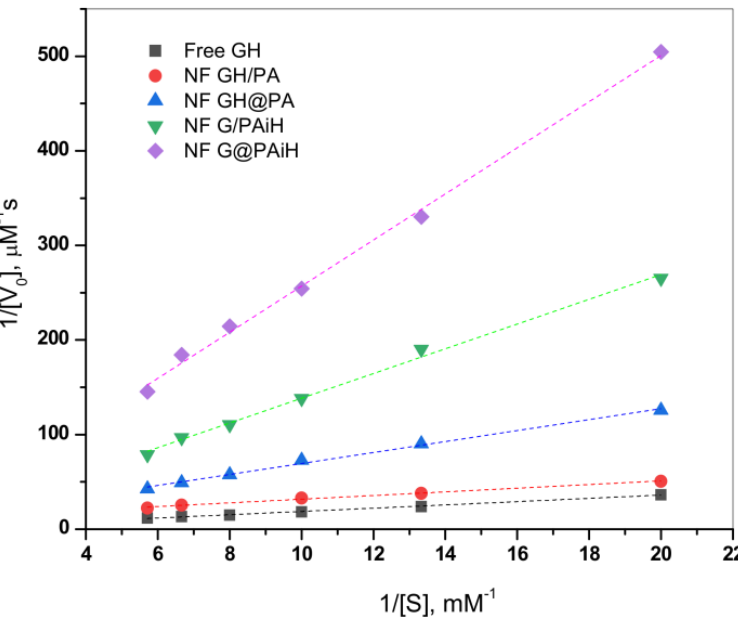
Figure 10. Double reciprocal Lineweaver-Burk plots for the PANF complexes in comparison to the free enzyme dyad. The kinetic data extracted from these plots are presented in Table 2. For sample designation and details, see Table 2 and the